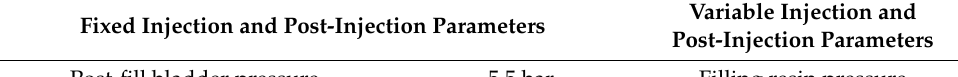
Table 2. Fixed and Variable injection and post-injection parameters for manufacturing a tubular section.